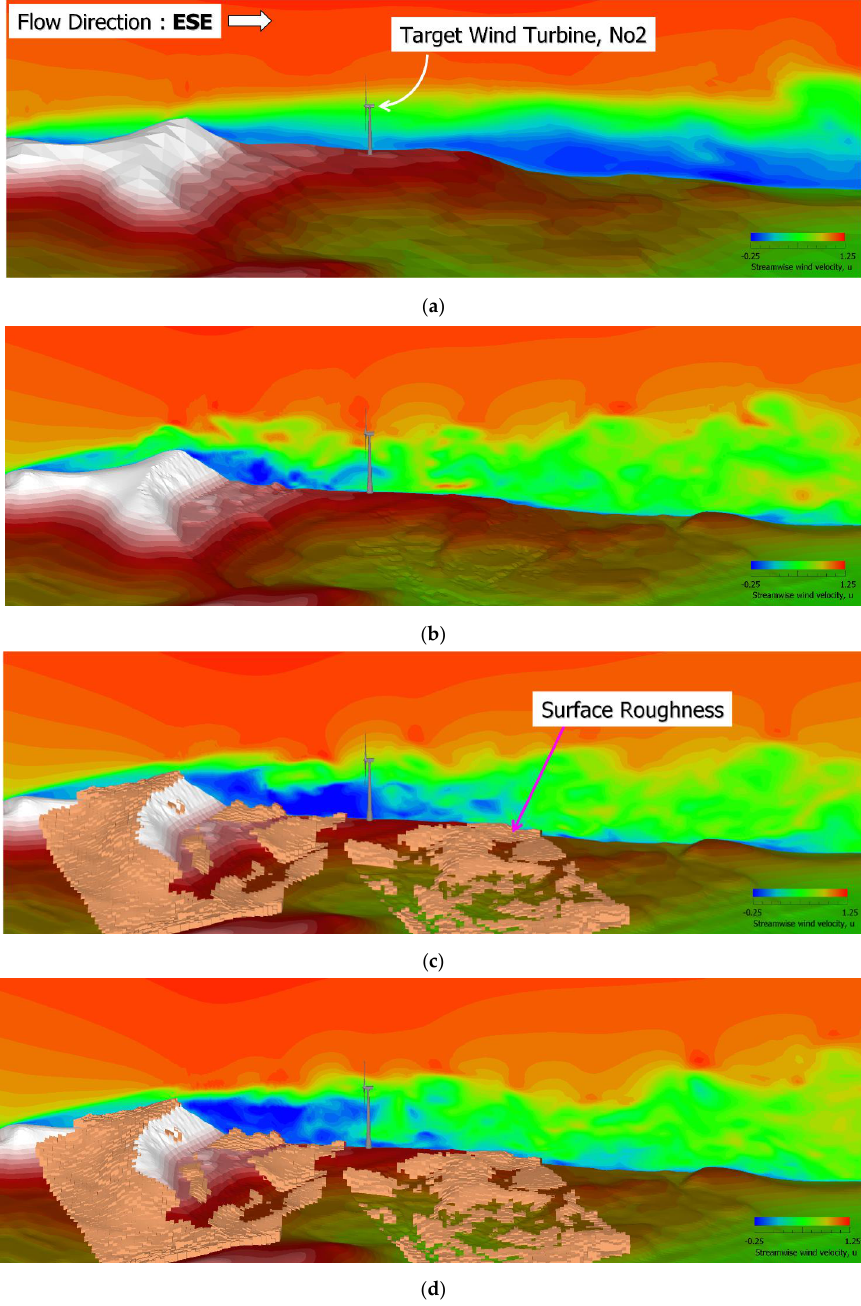
Figure 12. Instantaneous flow field at the wind turbine location for: ( a ) Case1, ( b ) Case2_1, ( c ) Case3, and ( d ) Case4. The effects of the wind turbines were not included in the simulations.